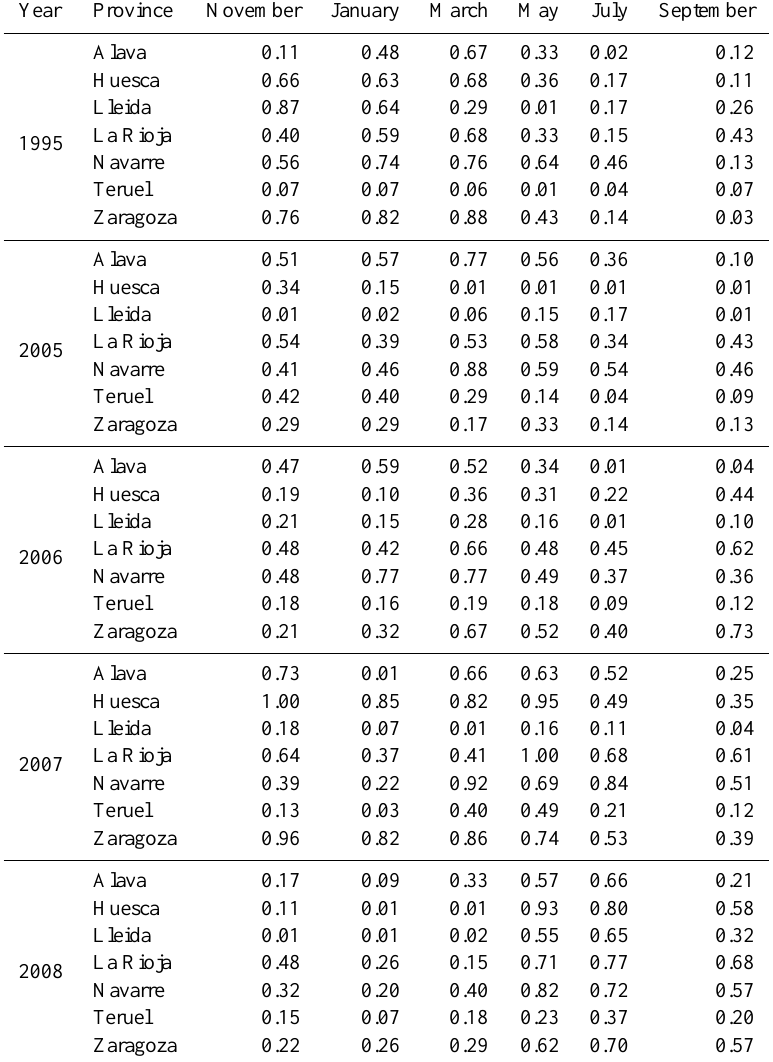
Table 1. Monthly drought indices for the main agricultural provinces in the Ebro River basin during two drought periods (1995 and 2005–